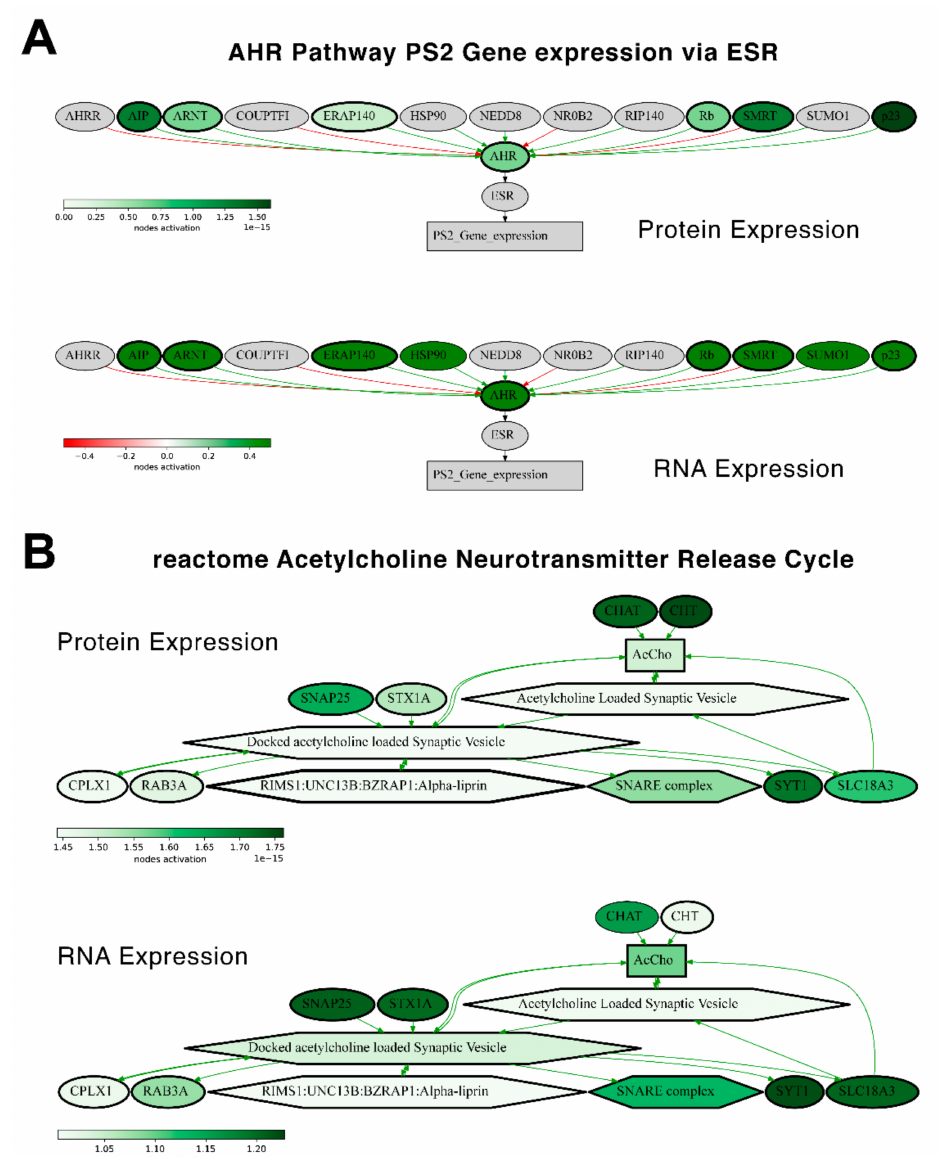
Figure 15. Molecular pathway activation maps estimated for protein expression ( top ) and RNA expres- sion ( bottom ) of an averaged Lung Adenocarcinoma sample. Activation maps of ( A ) “AHR Pathway PS2 Gene expression via ESR” and ( B ) “reactome Acetylcholine Neurotransmitter Release Cycle Main Pathway” pathways. Genes and nodes that preserved a concordance of activation/inhibition between RNA and protein expression are